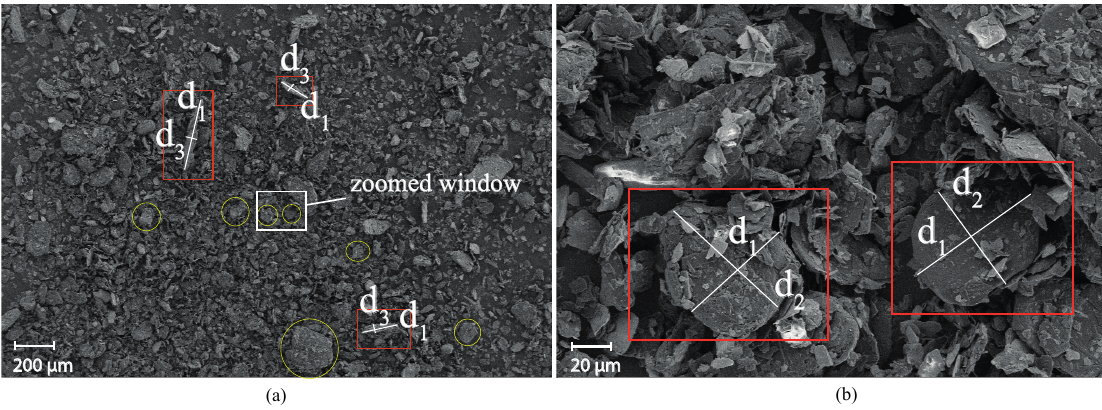
Figure 5. ( a ) SEM micrograph of graphite powder with ( b ) zoomed window. Labeled dimensions d 1 , d 2 , and d 3 are the major axis length, minor axis length, and height of the elliptical cylinders,